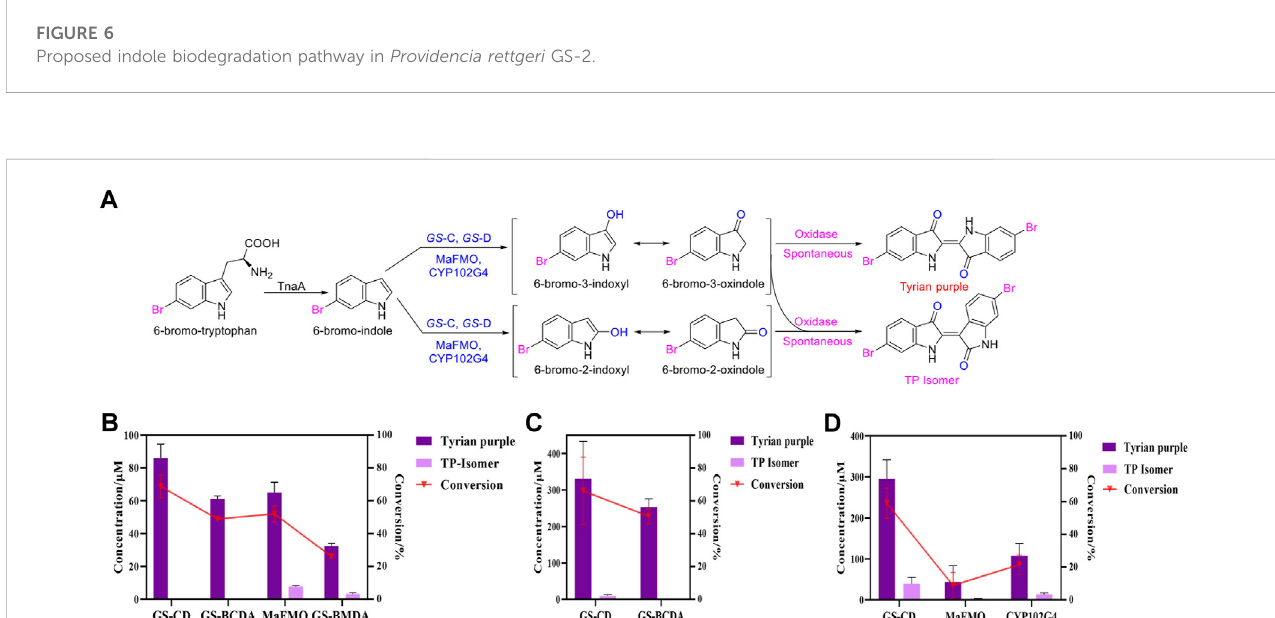
FIGURE 7 Production of Tyrian purple and TP isomer from 6-Br-tryptophan or 6-Br-indole using E. coli , expressing fl avin-containing monooxygenase from Providencia rettgeri GS-2, Methylophaga aminisul fi divorans (MaFMO), or cytochrome P450 enzyme CYP102G4. (A) Scheme of synthesis of Tyrian purple and